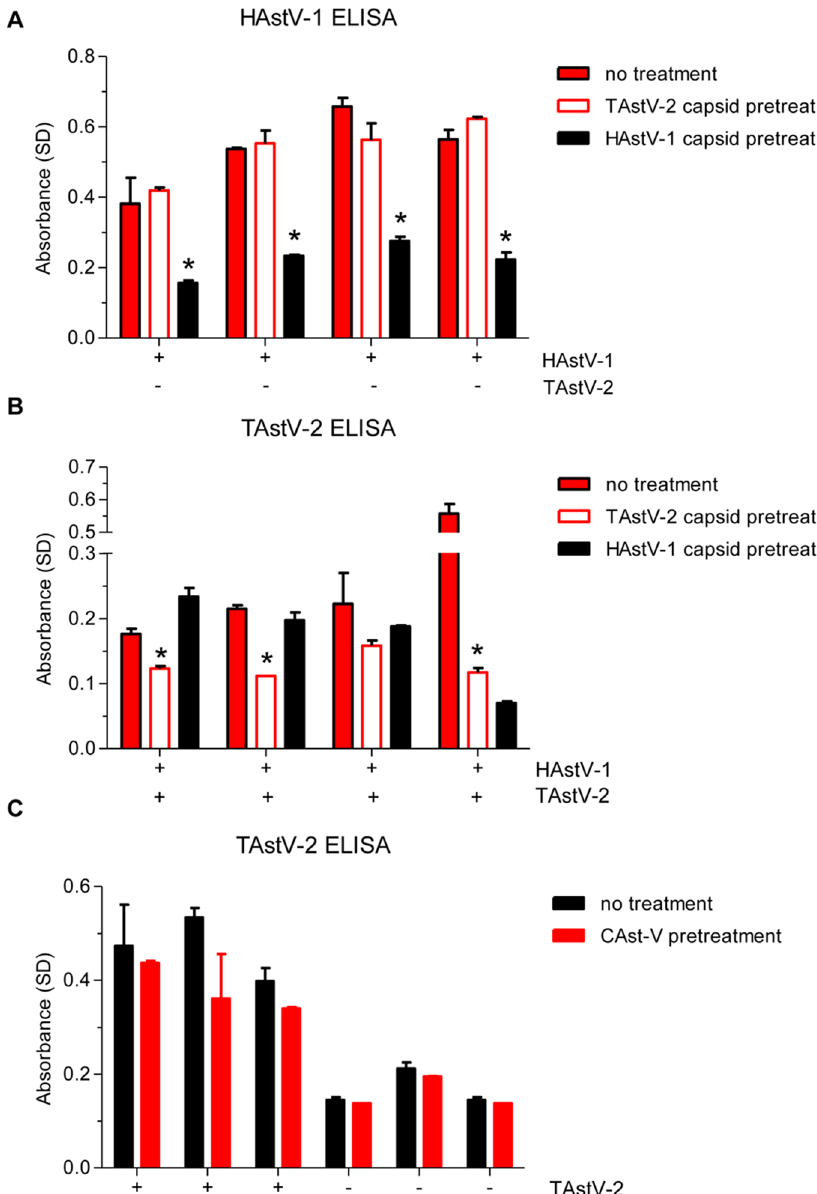
Figure 2. Specificity of the human sera to HAstV-1 and TAstV-2 capsid proteins. A) HAstV-1 positive sera were pre-incubated with PBS (no treatment) or HAstV-1 or TAstV-2 capsid proteins and binding to HAstV-1 capsid protein assessed by ELISA. B) TAstV-2 positive sera were pre- incubated with PBS (no treatment) or HAstV-1 or TAstV-2 capsid proteins and binding to TAstV-2 capsid protein assessed by ELISA. C) TAstV-2 positive and negative sera were pre-incubated with PBS (no treatment) or chicken astrovirus and binding to TAstV-2 capsid protein assessed by ELISA. A plus sign denotes serum sample was positive for indicated virus, and a minus sign denotes serum sample was negative for the indicated virus. Samples were tested in duplicate and data shown are mean values; error bars indicate SD. *p , 0.05.